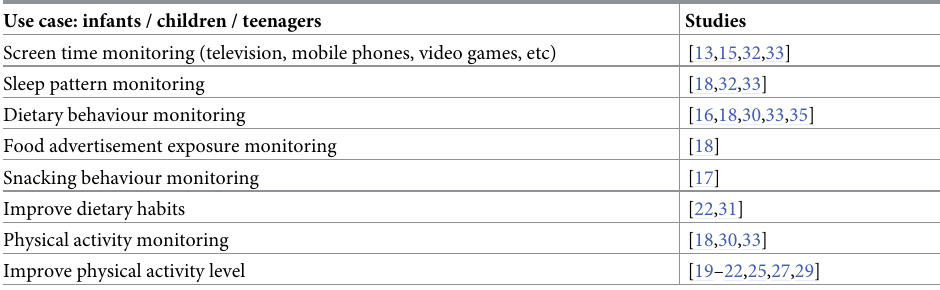
Table 2. Use cases for infants/ children/